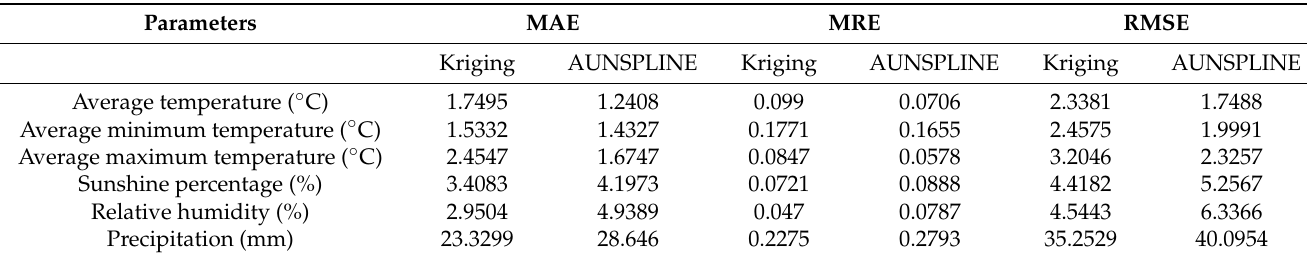
Table 1. Comparison of the interpolation results from the kriging and AUNSPLINE